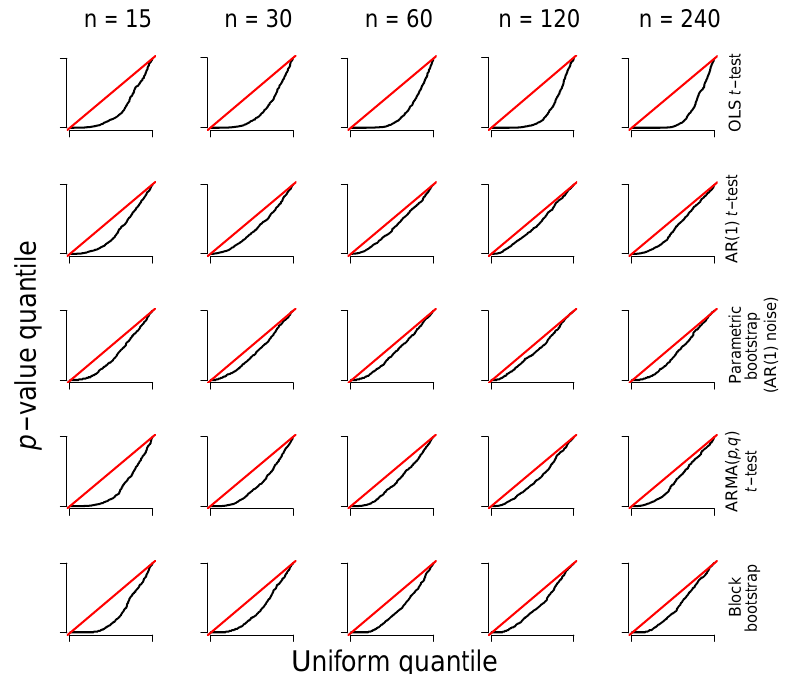
Figure 10. Same as Fig. 7 but with simulations from a fractional AR(1) model. While none of the methods perform very well here, the incorrectly specified parametric methods are better, especially in smaller